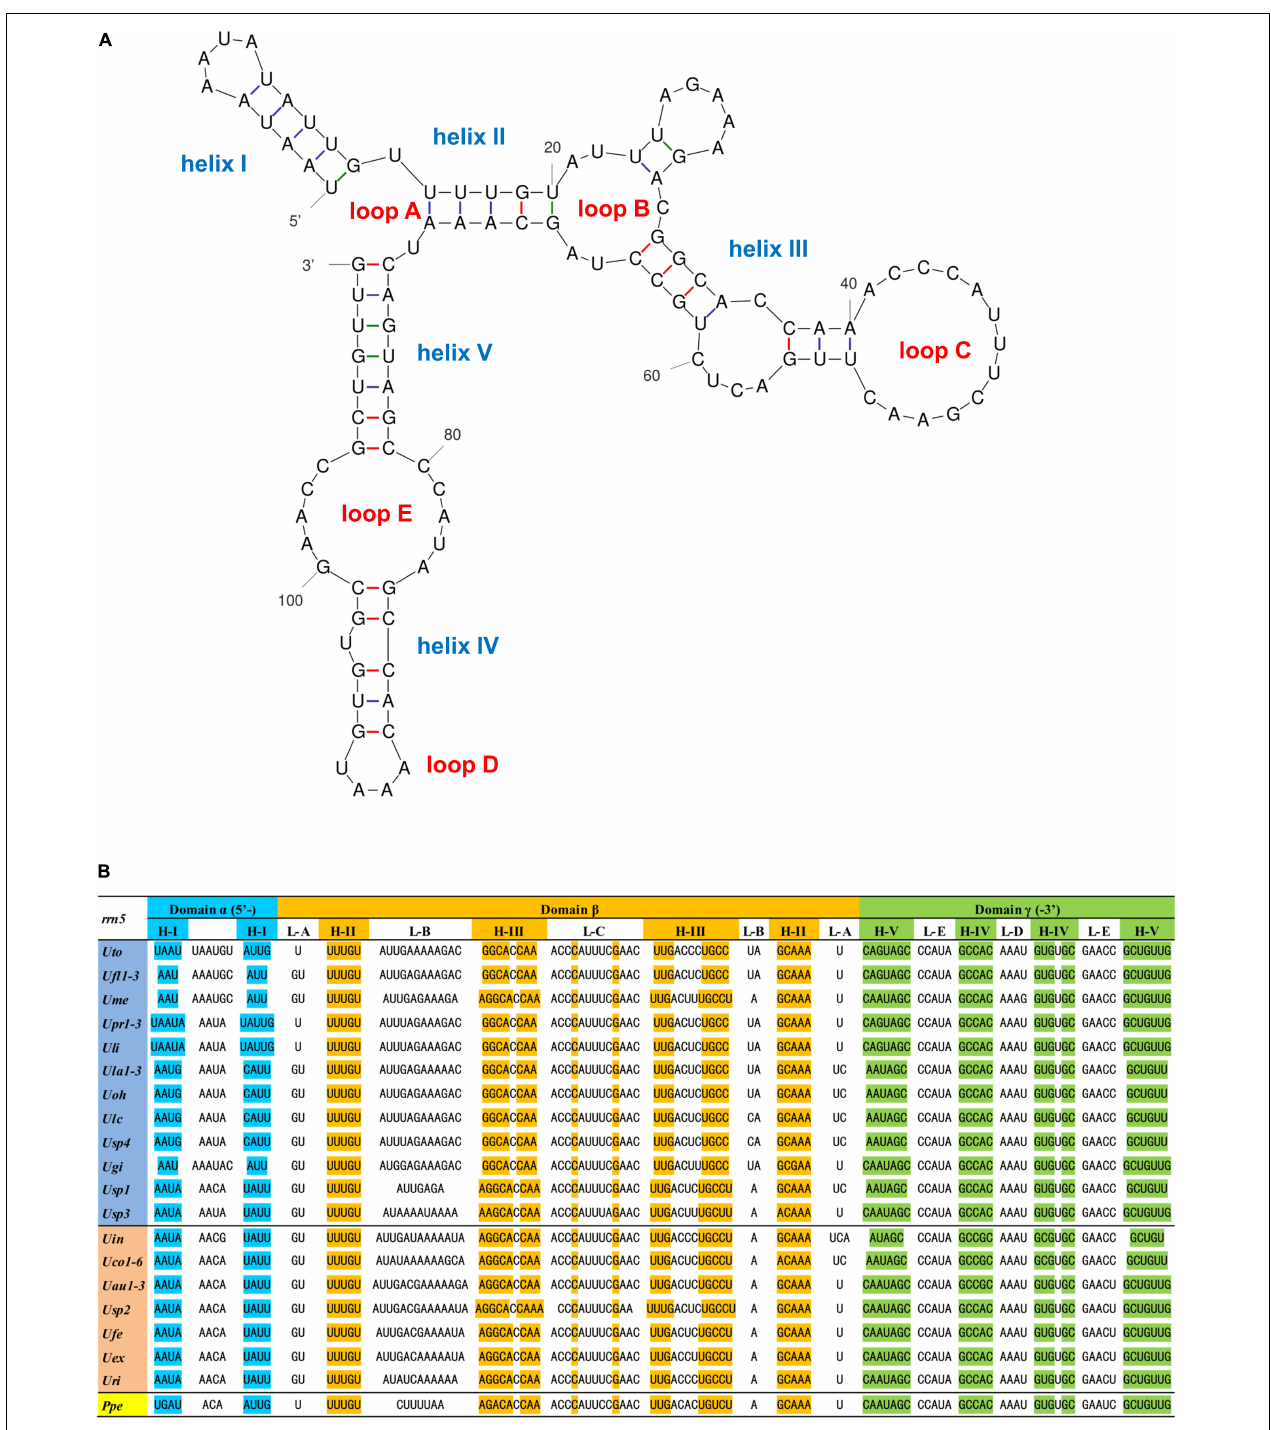
FIGURE 2 | The permuted 5S rRNA genes ( rrn5 ) detected in ulvalean mitochondrial genomes (A,B) . (A) Potential secondary structure of the mitochondrial 5S rRNA gene in Ulva prolifera ( Upr1-3 ). (B) Alignment of the mitochondrial 5S rRNA sequences in Ulvales. Shaded nucleotides indicated that bases could be paired.